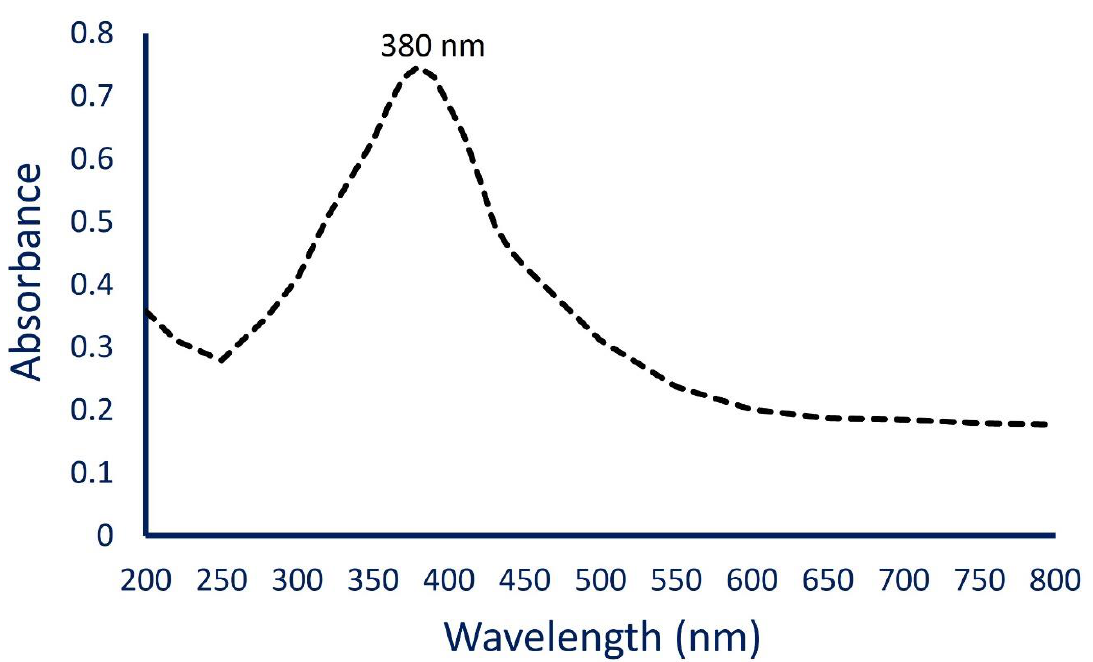
Figure 2. The UV-Vis spectroscopy for bacterially synthesized ZnO-NPs showed a maximum SPR at 380 nm.